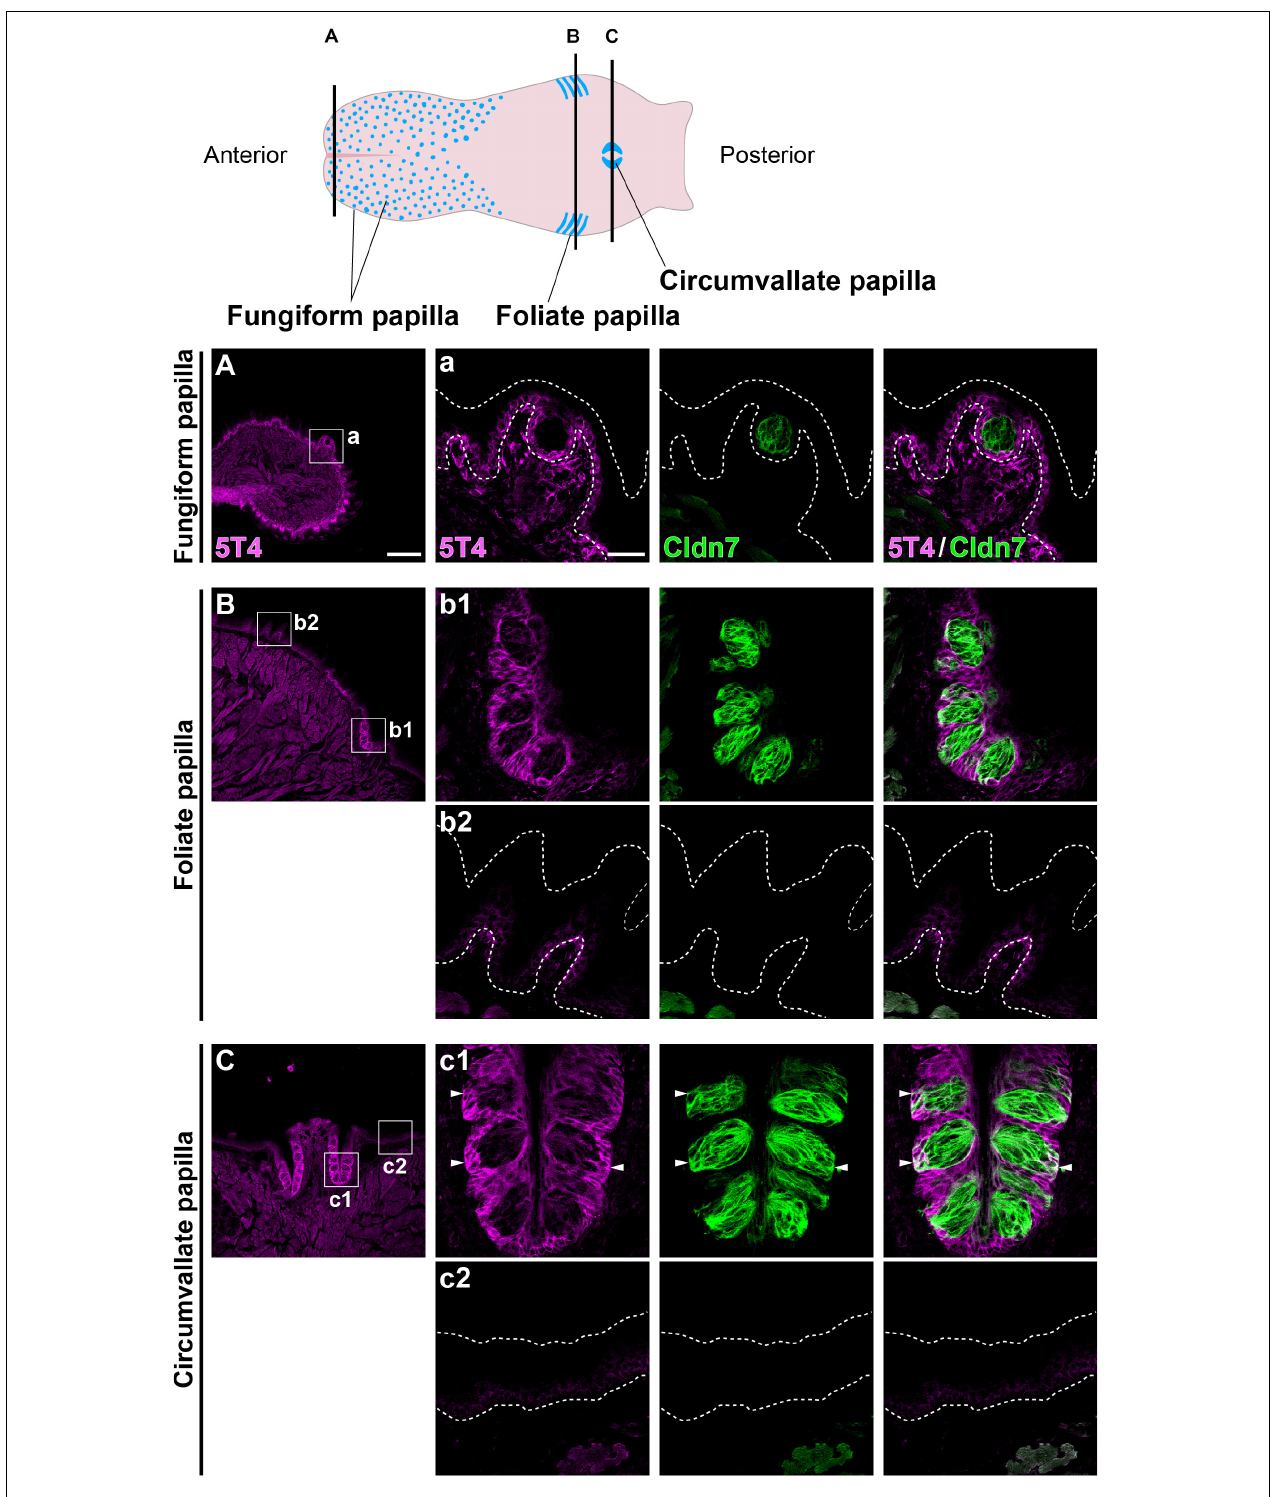
FIGURE 1 | 5T4 is abundantly produced within the foliate papilla and CVP. (Top) A schematic drawing of the mouse tongue as modified from Barlow (2015), showing the locations at which coronal sections (A–C) were prepared using a cryostat (Bottom). (A–C) IHC of the lingual epithelium, including the fungiform papilla (A) , foliate papilla (B) , and CVP (C) , of 6-week-old WT mice using antibodies against 5T4 (magenta) and Cldn7 (a marker of TBCs; green). Enlarged images of the regions enclosed by white squares in (A–C) are shown in (a, b1, b2, c1, and c2). All images represent single confocal optical sections [4.51 µ m/slice in (A–C) and 0.56 µ m/slice in (a, b1, b2, c1, and c2)]. Scale bars, 200 µ m in (A) and 30 µ m in (a). White dotted lines indicate the area of the lingual